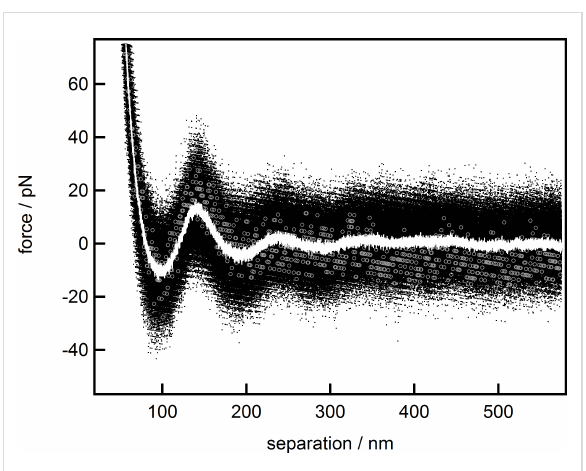
Figure 1: Force versus separation curve for the 2 wt % suspension. Grey open circles show a single force curve (number of data points reduced by a factor of 10 for better visibility), with only a single discernible maximum of the oscillatory structural force. Black dots show the combination of 67 individual measurements (1.3·10 6 data points) with two detectable maxima. White dots represent the binom- inal smooth (width 10 3 points) of the combined data showing a third maximum.